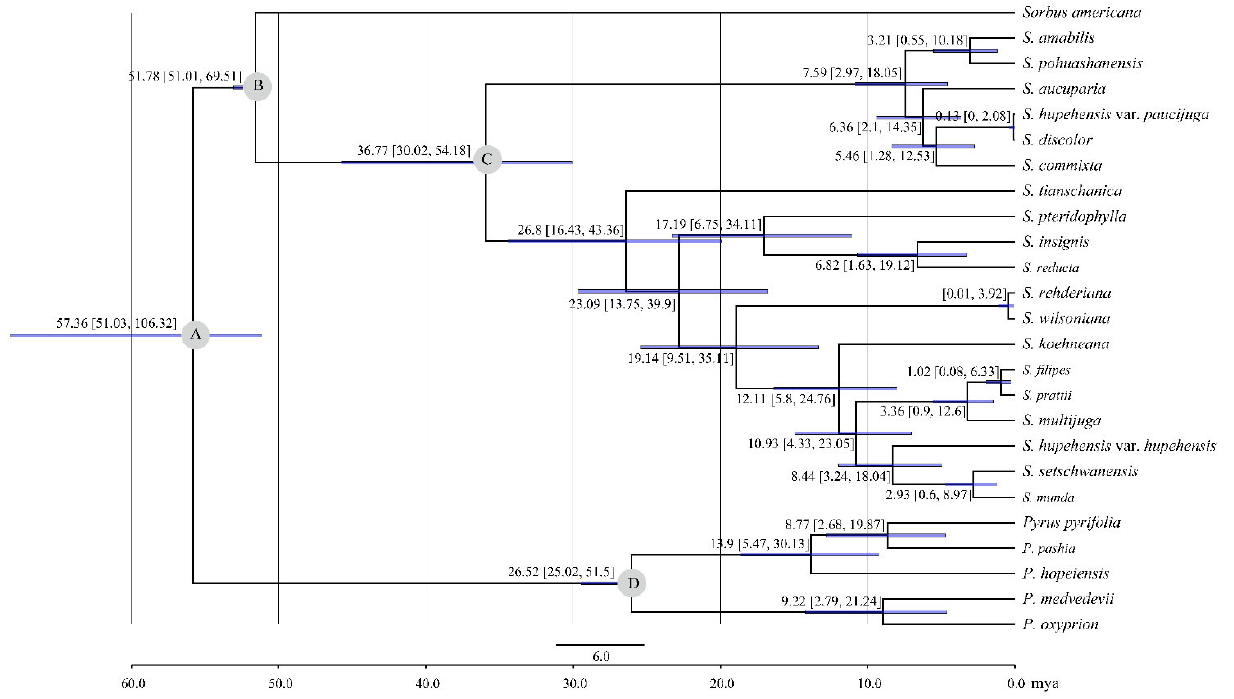
Figure 7. Divergence time of 20 Sorbus species derived from BEAST. A, B, C, and D with gray circle represent calibration points. Blue bars represent 95% highest posterior density.